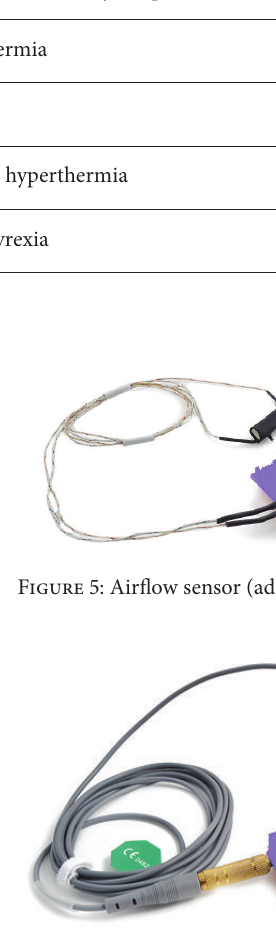
Figure 6: Body temperature sensor (adapted from